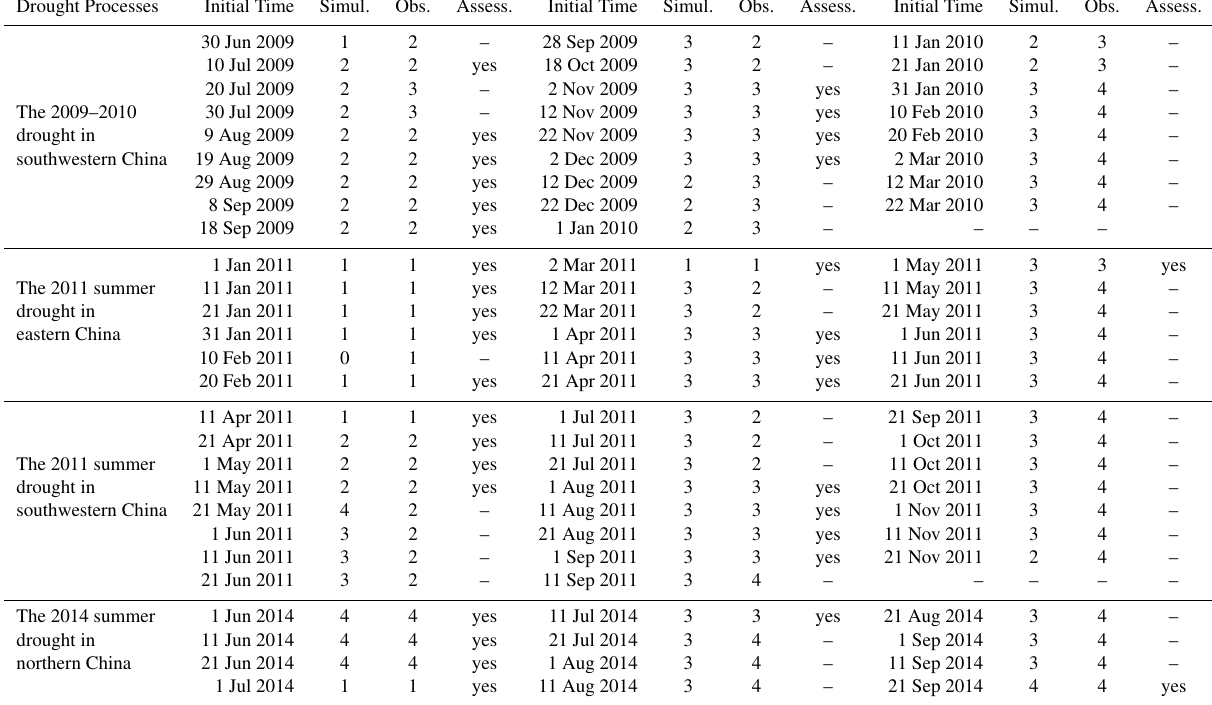
Table 8. Simulation assessment of recent severe drought processes in China forced with the NCEP/NCAR reanalysis datasets. The numbers 0–4 in the below table represent different drought states: no drought (0), drought occurrence (1), drought persistence (2), drought reces- sion (3), and drought relief (4). As well as this, the abbreviation “Simul.” and “Obs.” represent the simulated and observed drought outlooks, respectively. The abbreviation “Assess.” in the column refers to whether the simulation and observation agree or not.